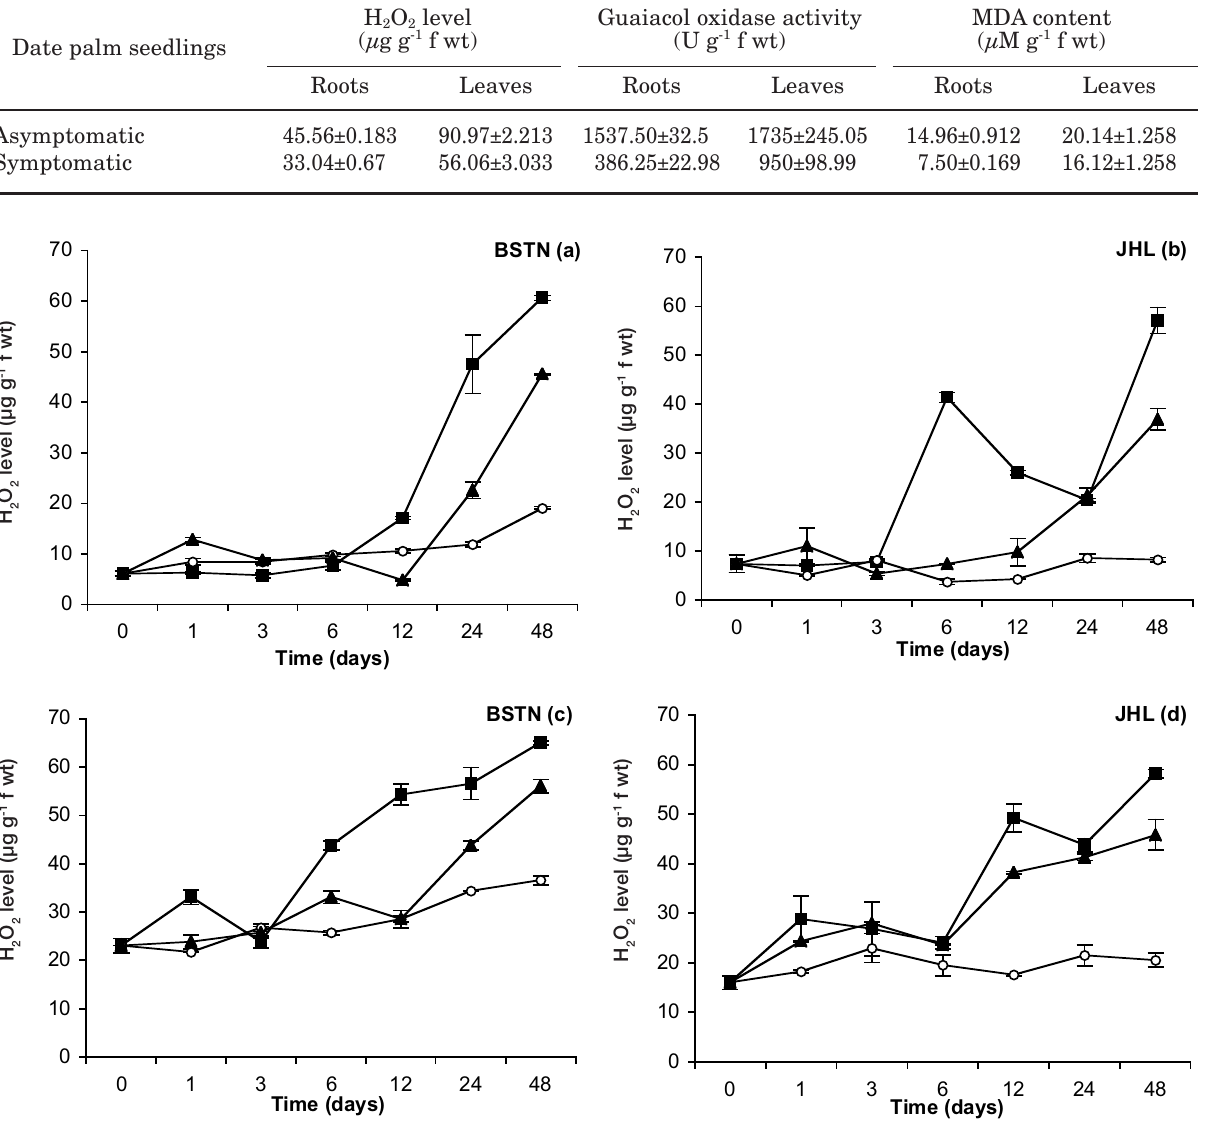
Fig 1. Changes in H O level in seedling roots (a, b) and leaves (c, d) of date palm cultivars BSTN and JHL after inocula- 2 2 tion with Fusarium oxysporum f. sp. albedinis ( Foa ) ( ▲ ); treatment with jasmonic acid ( ■ ); distilled water control ( O ).